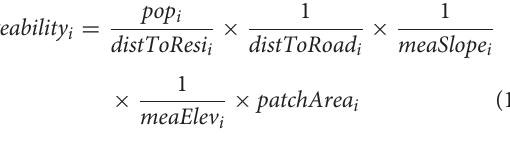
a population decline of 58%. The other four scenarios were set at equal intervals between 0 and 223 ha year − 1 ( Table 1